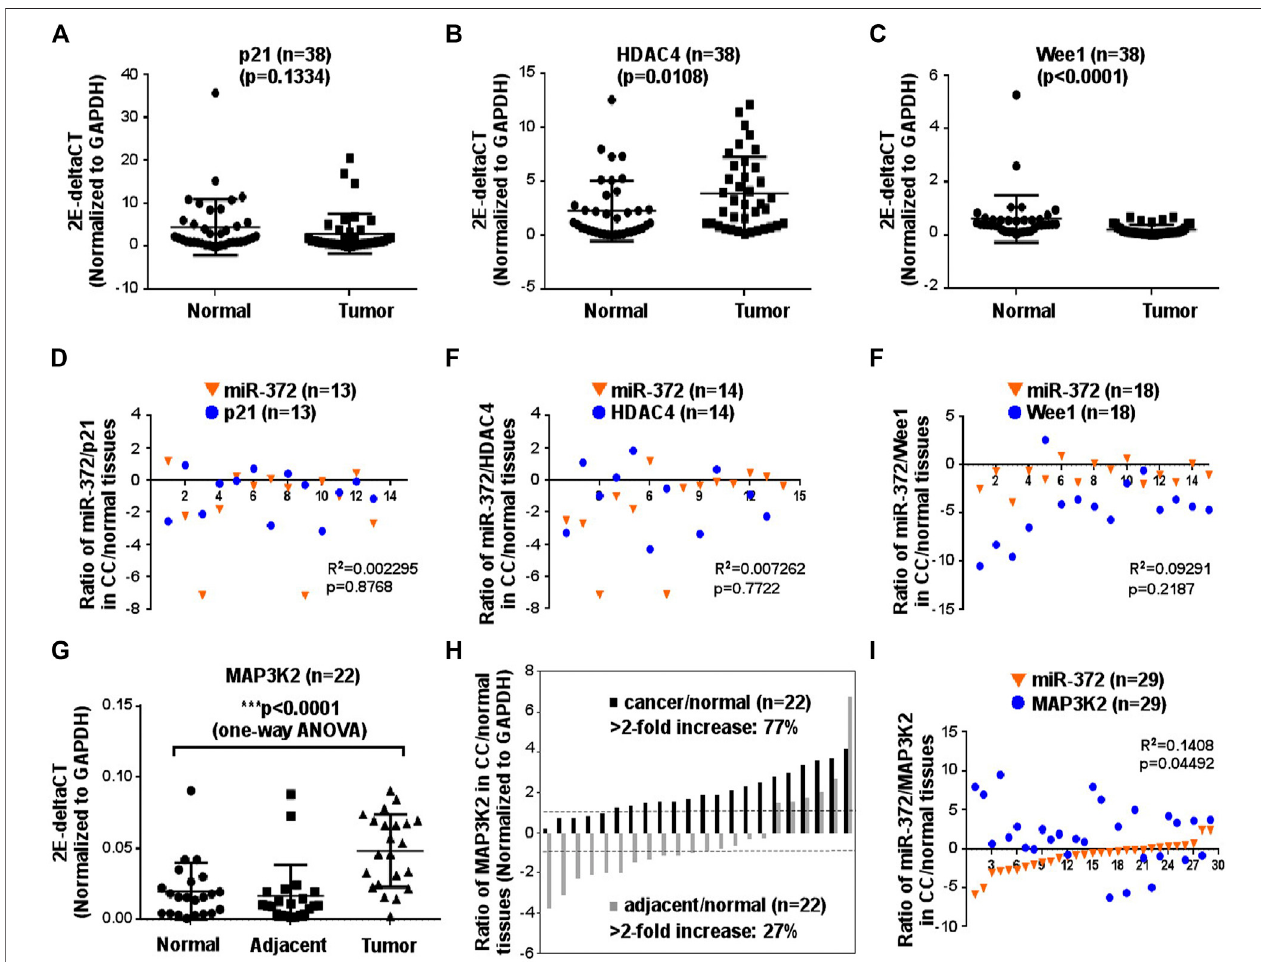
FIGURE 4 | MAP3K2 may be the potential target of miR-372-3p in colon cancer tissues. (A – C) mRNA expression levels of the potential targets of miR-372-3p including p21, HDAC4, and Wee1, are displayed as 2E-deltaCT (normalized to GAPDH) in colon cancer or matched normal tissues. ** p < 0.01 vs. normal tissues(Mann Whitney test). (D – F) Correlation between miR-372-3p expression and its potential targets p21, HDAC4, and Wee1 in colon cancer. The Y-axisexhibits the log2 value of the ratio of miR-372-3p (orange triangle) and p21, HDAC4, or Wee1 (blue circle) expression levels between colon cancer and matched normal tissues, and the X-axis exhibits the number of samples. The correlation between miR-372-3p and p21, HDAC4, or Wee1 was statistically analyzed using the GraphPad Prism software. (G) MAP3K2 mRNA expression (normalized to GAPDH) in colon cancer, matched adjacent and normal tissues. *** p < 0.0001 vs. normal tissues (one-way analysis of variance). (H) Expression patterns ofMAP3K2in coloncancer and matched adjacent tissues.Each bar presents thelog2 valueoftheratioofMAP3K2 expression levels between colon cancer and matched normal tissues or adjacent and normal tissues from the same patients. (I) Correlation between miR-372-3p and MAP3K2 expression levels in colon cancer tissues. The Y-axis exhibits the log2 value of the ratio of miR-372-3p (orange triangle) and MAP3K2 (blue circle) expression levels, and the X-axis exhibits the number of samples. All qPCRs were performed in three independent experiments with three replicates per